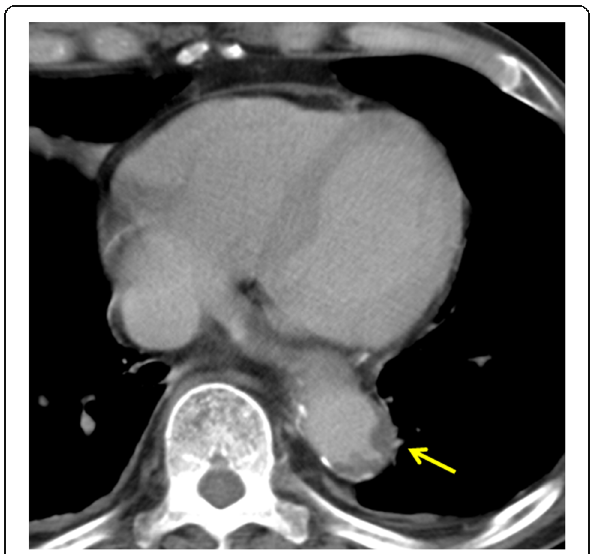
Fig. 2 Computed tomography (CT) scan revealing shaggy aortic wall due to atherosclerosis